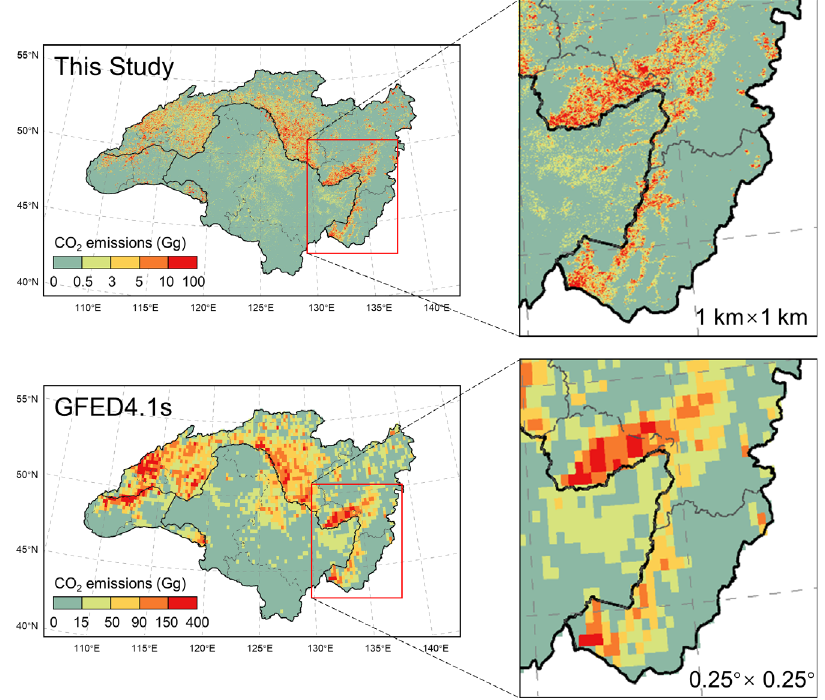
Figure 8. Comparison of annual CO 2 emissions from OBB between this study with a 1 km grid and GFED4.1s with a 0.25° grid in the Amur-Heilong River Basin during the 2003–2016 period.